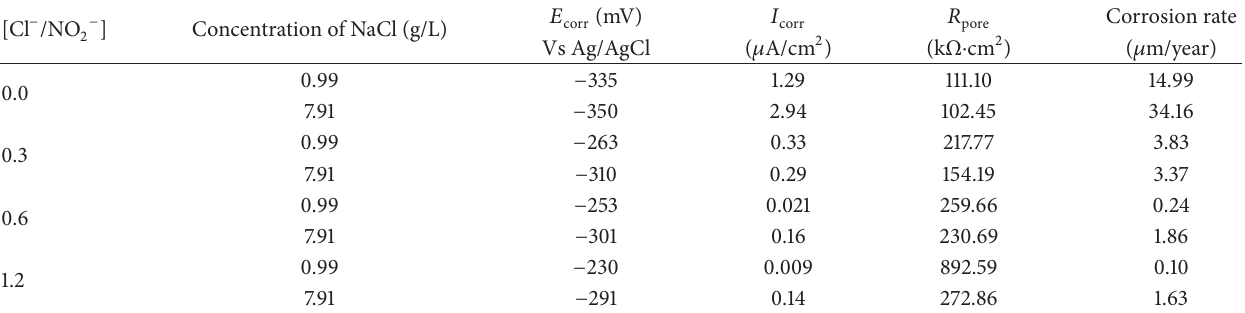
Table 4: Electrochemical parameters were extracted after fitting of potentiodynamic plots in Tafel region.